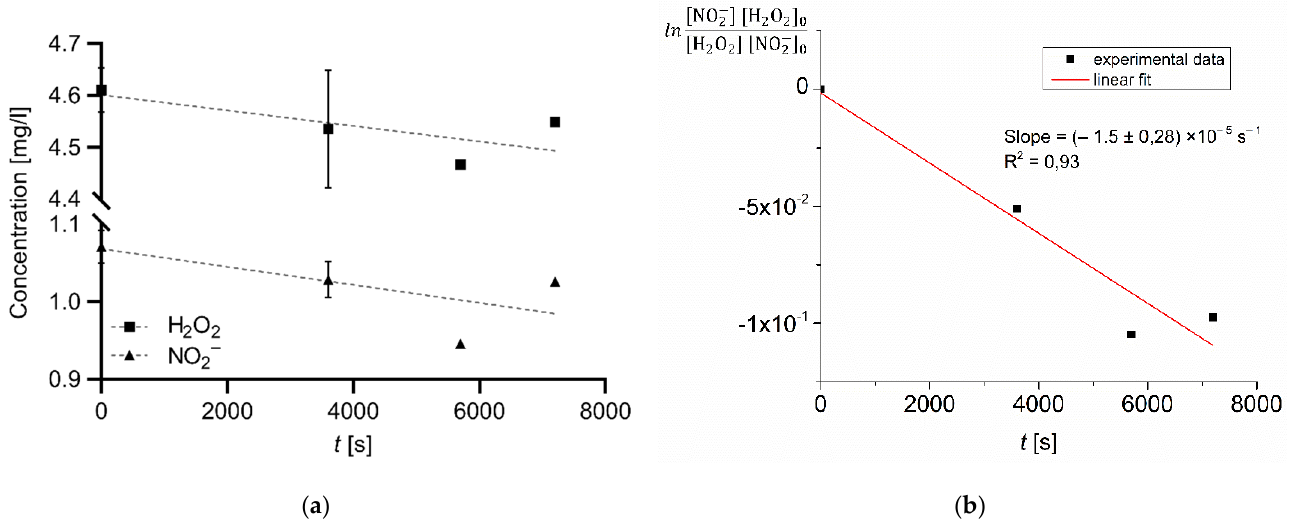
Figure 7. ( a ) Post-treatment evolution of [NO 2 − ] and [H 2 O 2 ] in a sample volume of 50 mL of PAW treated for 20 min (lines are a guide to the eye). ( b ) Plot of (10) as a function of time.